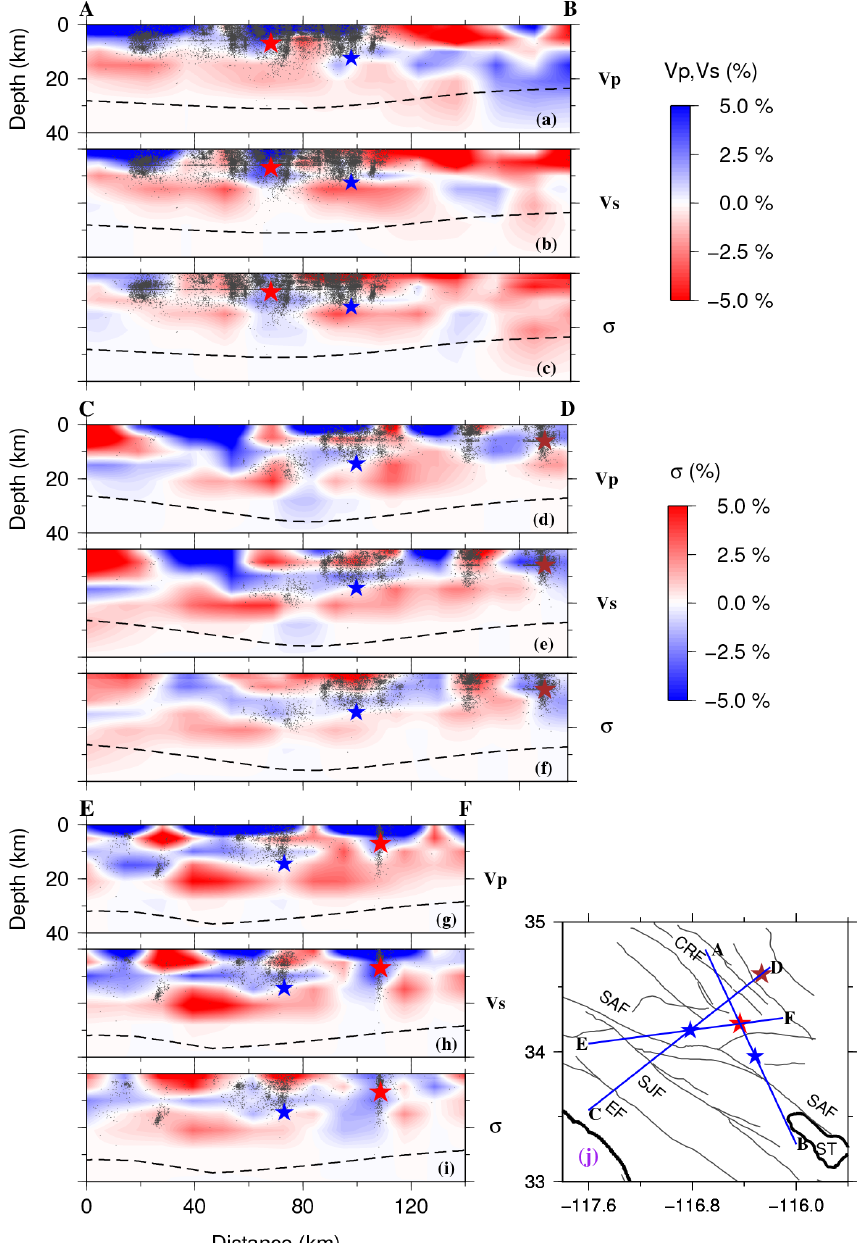
Figure 14. Vertical cross sections of P wave velocity, S wave velocity, and Poisson’s ratio images ( m 4 ) along profile AB (a–c) , CD (d–f) and EF (g–i) as indicated on the inset map (j) . Low velocity and high Poisson’s ratio are shown in red color, while high velocity and low Poisson’s ratio are represented by blue color. The scales for the velocity and Poisson’s ratio σ perturbations (in %) are shown on the right. Small grey dots denote events with magnitudes greater than 1.5 between January 1992 and November 2013 that are located within 3.0km width along each profile. The hypocenters for the Landers mainshock ( M w 7.3) hypocenter at 7.0km depth and the Hector Mine earthquake at 6.0km are shown by the red and brown star, respectively. The hypocenters for the Joshua Tree earthquake at 12 . 4km and the Big Bear earthquake at 14 . 4km are indicated by blue stars. The dashed lines represent the Moho discontinuity obtained by Zhu and Kanamori (2000). CRF is short for the Camp Rock fault, also indicated on the inset map (j)